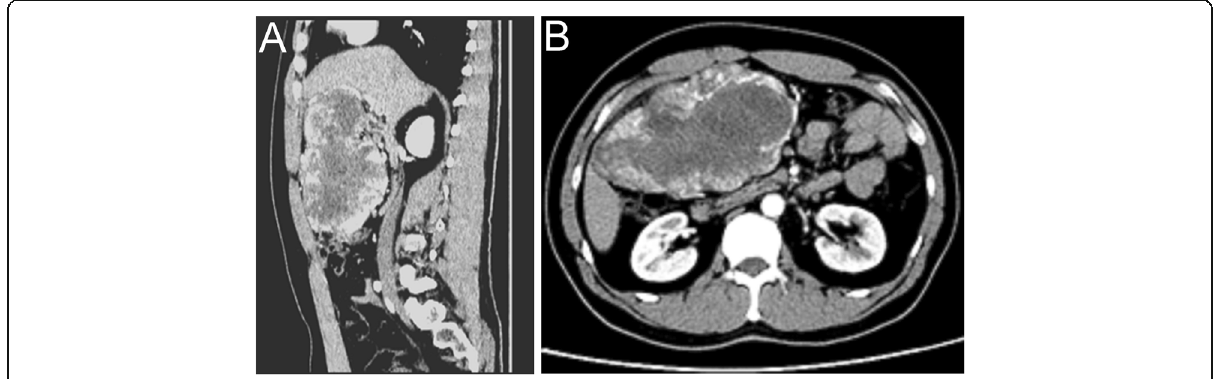
Fig. 1 Abdominal CT scan shows a mass located in the right upper abdominal cavity and its three-dimensional reconstruction image. a : sagittal position, b : transverse